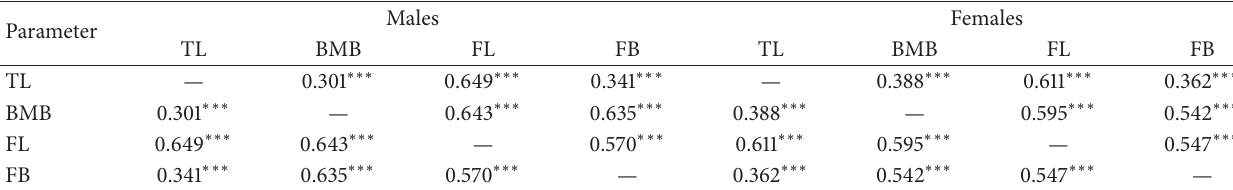
Table 2: Pearson correlation within the lower limb dimensions (in cm).